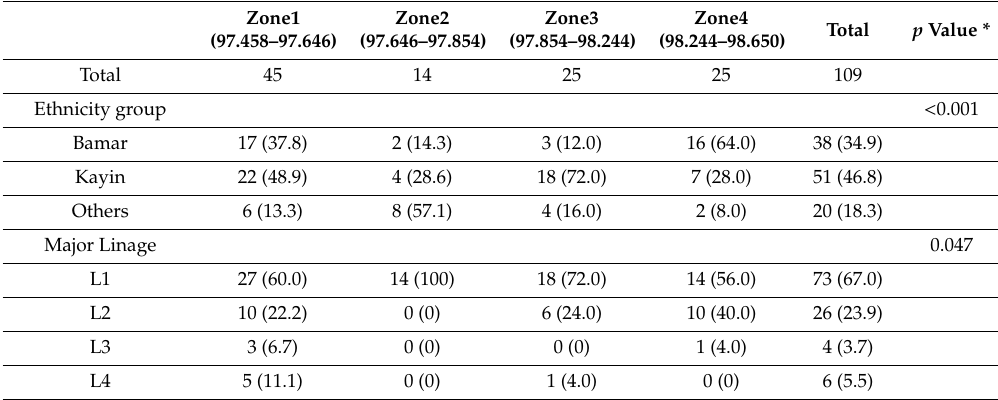
Table 3. Distribution of Patient Ethnicity and Major Lineages of Mycobacterium tuberculosis .